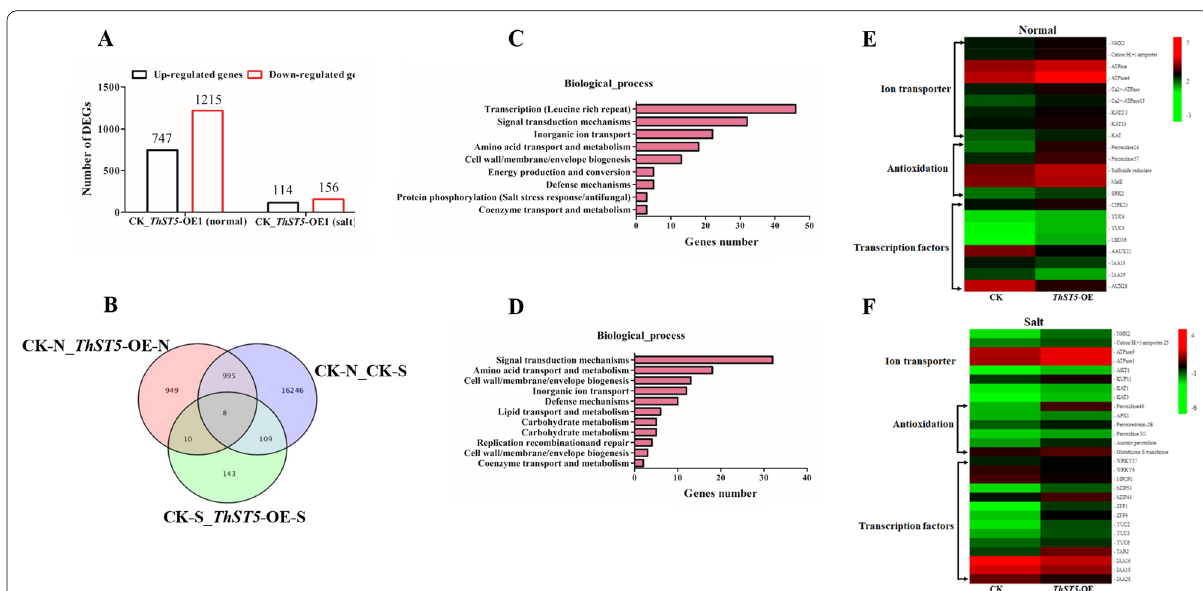
Fig. 6 Expression profiling analysis of cotton seedlings under normal and salt conditions. A The number of up-regulated and down-regulated gens in CK versus ThST5 -OE under normal and salt conditions. B Comparison of DEGs from CK and ThST5 -OE under normal growth condition (CK-N_ undefinedThST5 -OE-N), CK and ThST5- OE under saline condition (CK-S_ ThST5 -OE-S), and CK under normal growth condition and saline condition (CK-N_CK-S) by Venn diagram. Numbers correspond to the count of overlapped or unique DEGs in each comparison group. C , D Gene ontology (GO) categorization of all DEGs between ThST5 -OE and CK under normal conditions ( C ) and under salt stress ( D ). E , F Hierarchical clustering analysis of ThST5 regulated salt-responsive genes regulated by ThST5 under normal ( E ) and under salt stress conditions ( F ). The heatmap is the representation of fold changes in abundance of the mRNAs in two groups. The abscissa donates sample name and ordinate contains the DEGs. Results were displayed as log2 ratio. The colors correspond to the level of gene